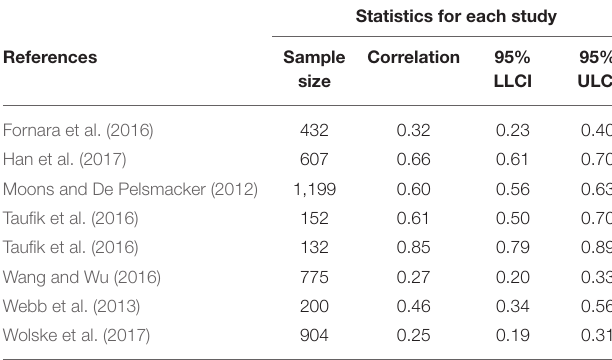
TABLE 5 | Summary of ES of the association between emotions and energy saving behaviors (or